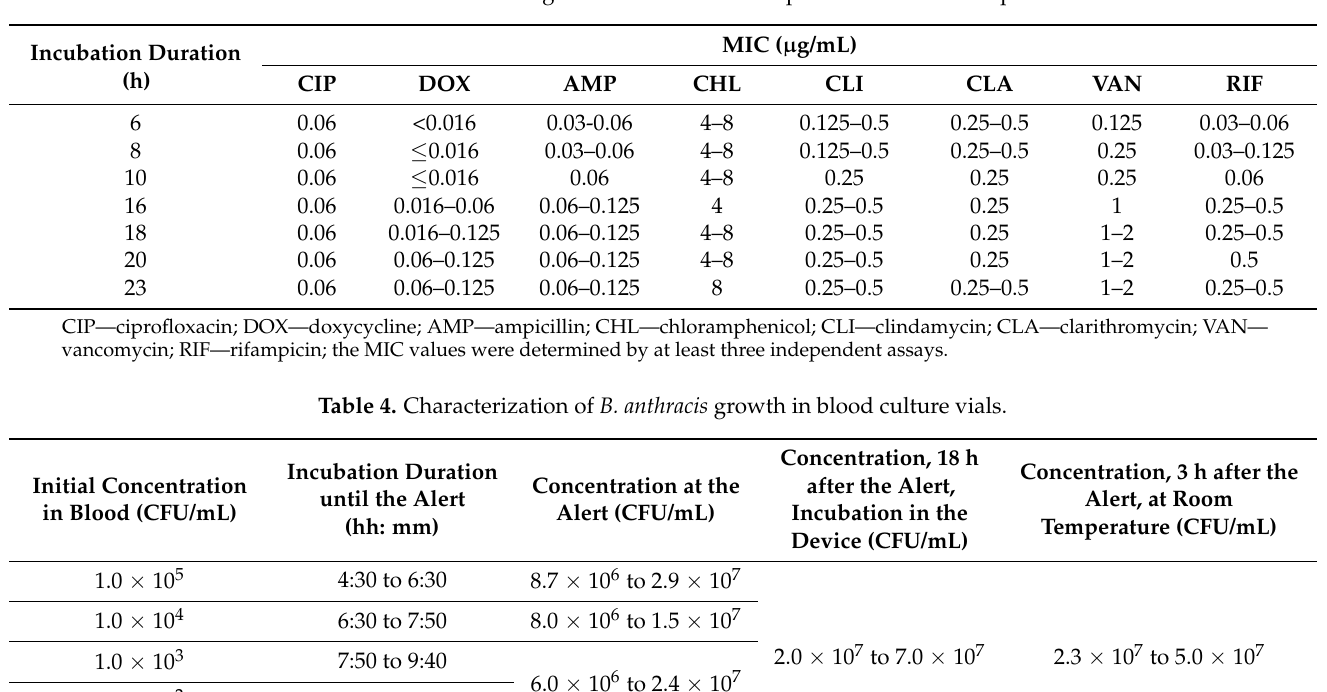
Table 3. Etest MIC values of germinated B. anthracis spores at various time points.